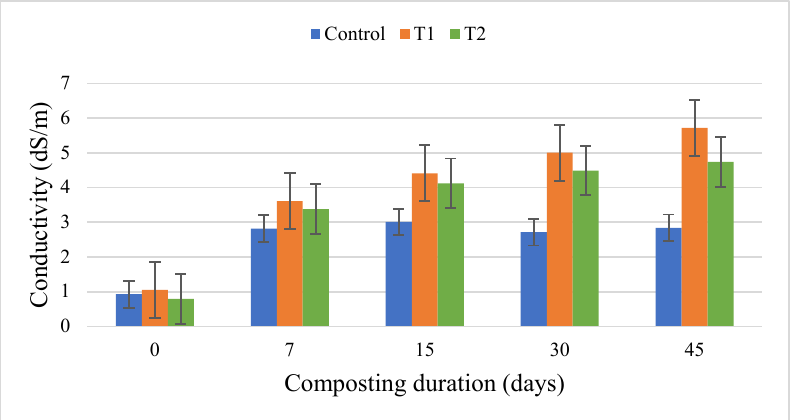
Figure 6. Conductivity changes in the control, T1, and T2 samples at days 0, 7, 15, 30, and 45.